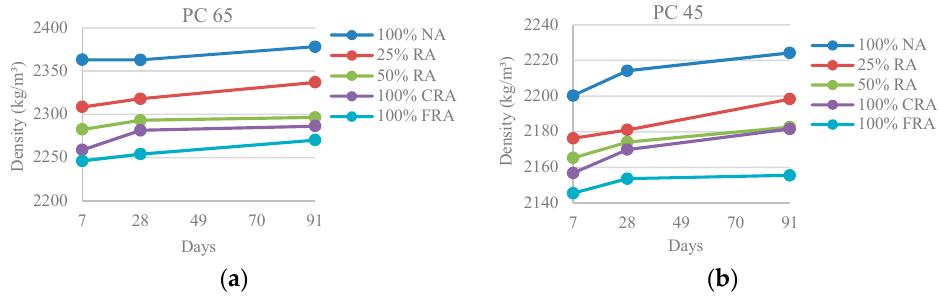
Figure 2. ( a ) Density at 7, 28 and 91 days (PC 65); ( b ) Density at 7, 28 and 91 days (PC 45).